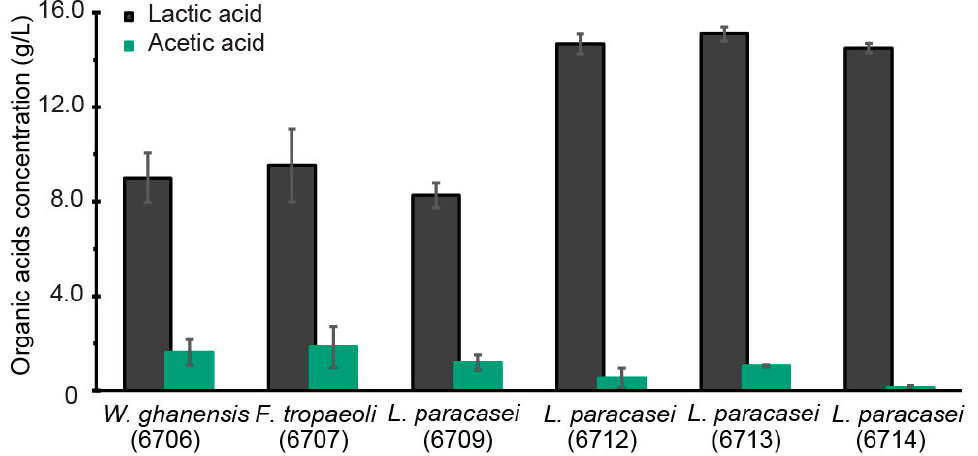
Figure 2. Organic acid production by six selected LAB strains during microbioreactor fermentation with an operating volume of 6 mL, initial pH of 6.8, and 37 °C. The values are shown as the mean ± standard deviation, n = 3 . The specific LA enantiomer was not determined.